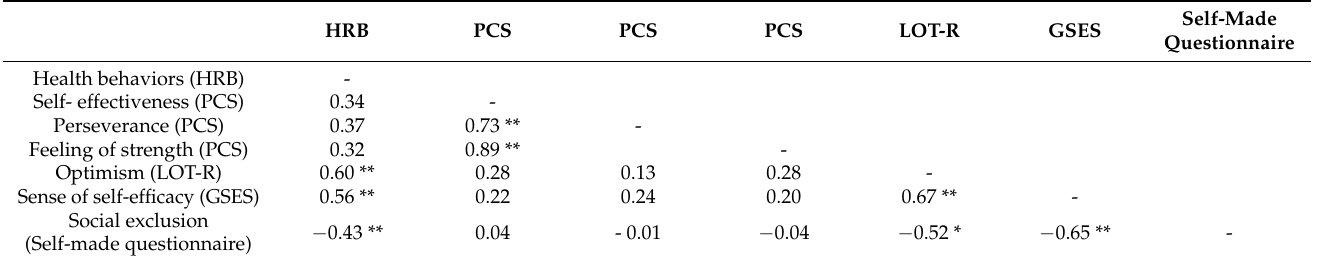
Table 2. Correlations between the studied variables in November